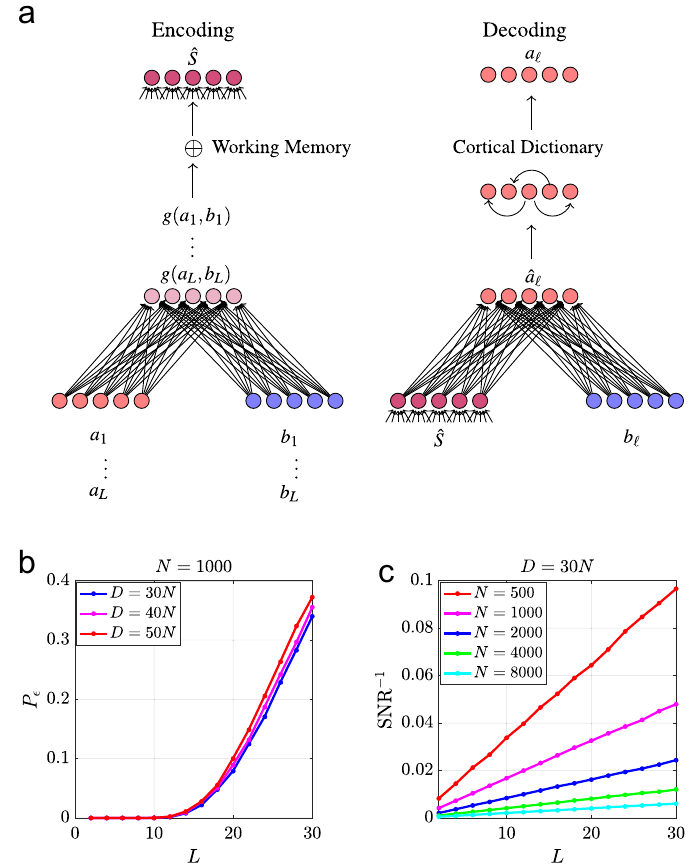
Figure 1. ( a ) A schematic of the network used to bind objects/attribute pairs ( a , b ) to form the knowledge S alongside the network used to decode an object a ℓ from structure unbinding error P ǫ shown as a function of structure length L for N 1 10, 000 structures ( c ) SNR − shown as a function of L for several values of N averaged over 10, 000 (cid:31)